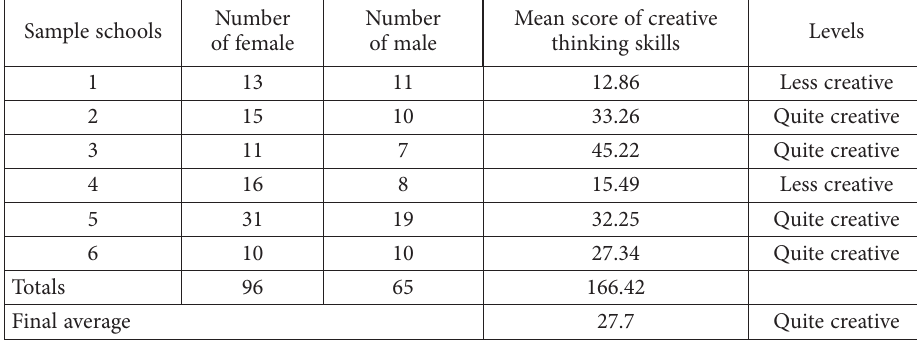
Table 2. The mean score of students’ creative thinking skills in each sample schools (source: created by authors) Sample schools